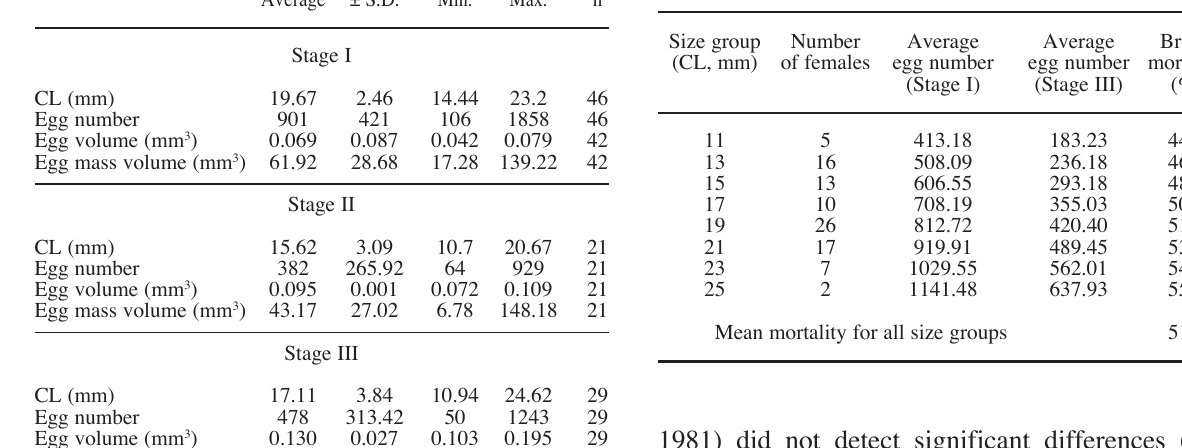
T ABLE 3. – Percent brood mortality in A. grayi per maternal size group based upon pairwise comparisons of egg numbers in embry- onic stages I and III. Regresssion equations for Stage I and III were used to estimate average egg numbers per size group; TL = total length of ovigerous females.